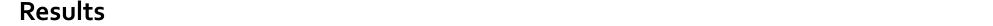
Table 2. Baseline characteristics of target lesions that underwent prostate MRI-targeted biopsy. Data are presented as number (%), mean ± standard deviation, and median (interquartile range). a Cut-off value of the elastography strain ratio for predicting prostate cancer using the Youden index. b Cut-off value of the elastography strain ratio for predicting clinically significant prostate cancer using the Youden index. MRI, magnetic resonance imaging; PI-RADS, Prostate Imaging Reporting and Data System.